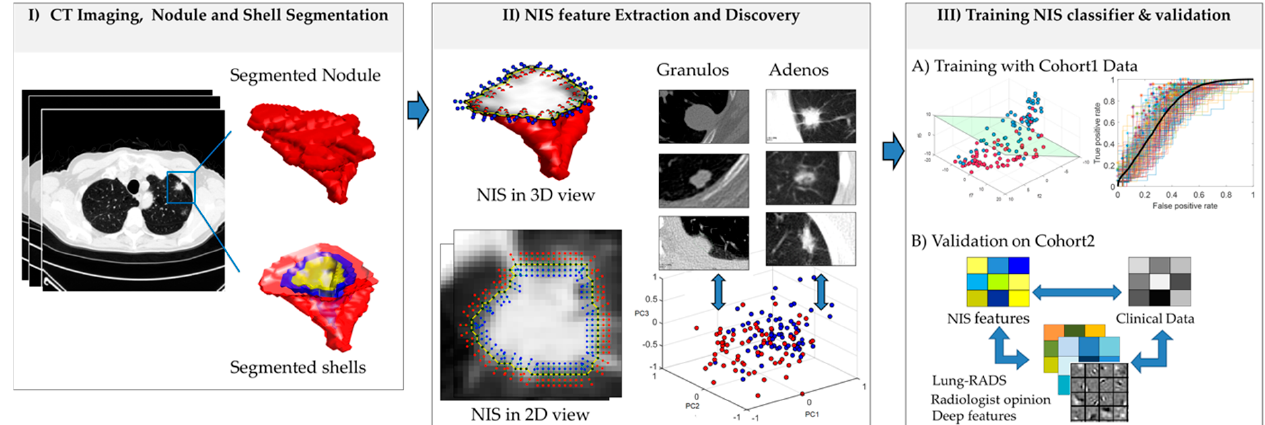
Figure 1. Illustrative flowchart depicting the NIS approach.